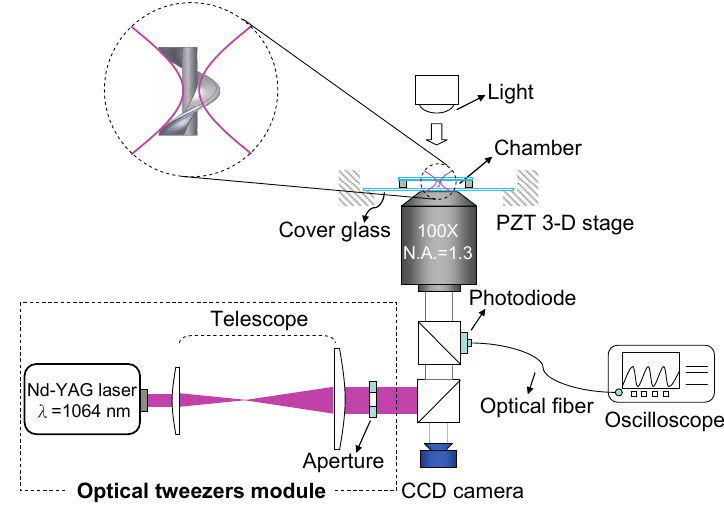
Figure 4. Diagram of the optical tweezers system.